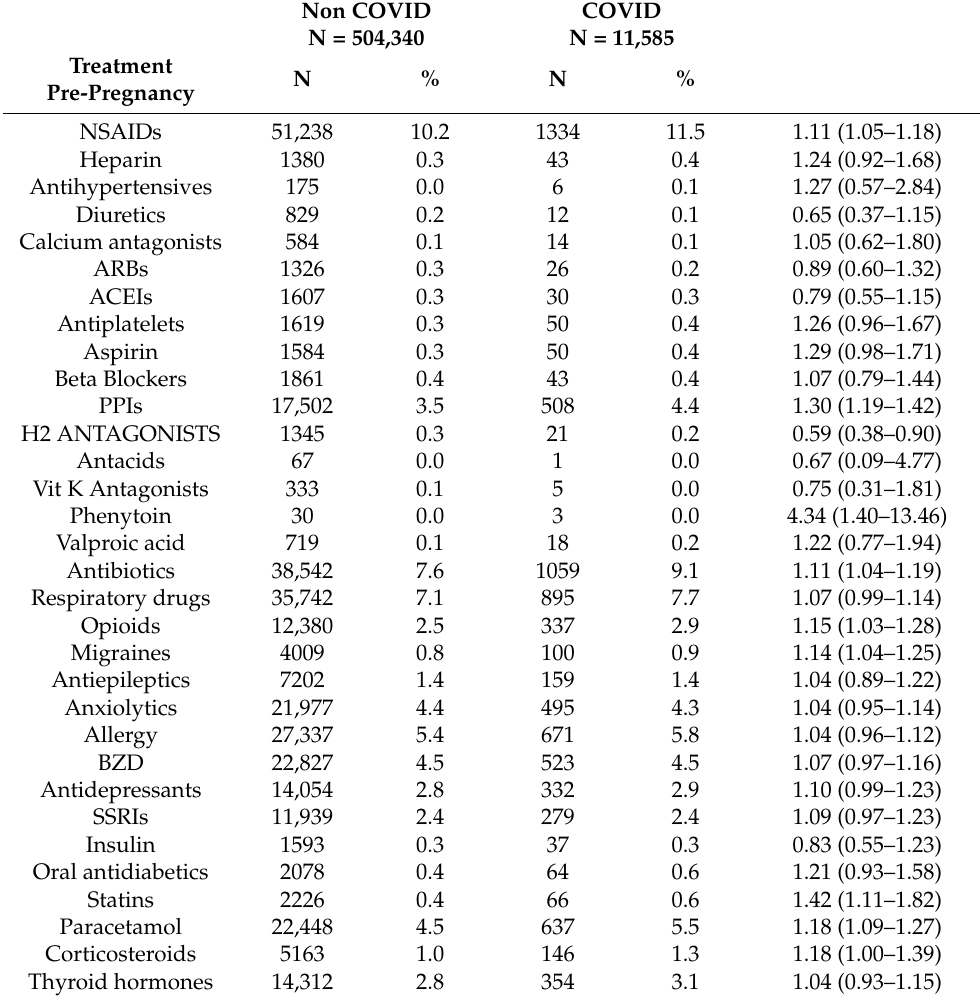
Table 3. Baseline characteristics and its association with COVID